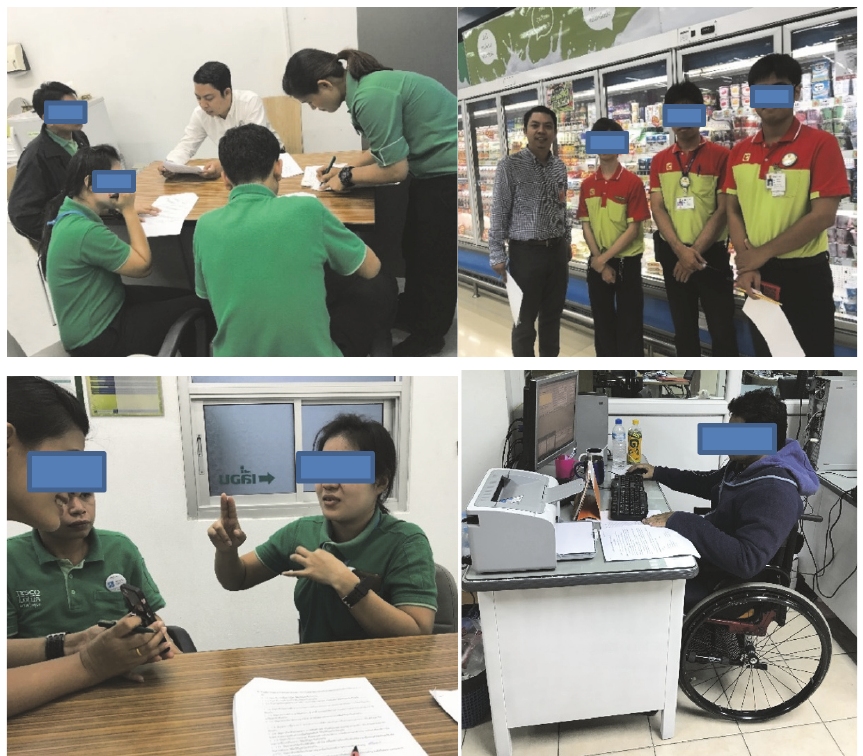
Figure 1: The researcher collected data in Phase 1 using questionnaires, observations, and interviews with three groups of disabled people in major retail and wholesale companies in Bangkok. The trainer interviews were conducted and data was collected from 120 questionnaires [2]. Source: the current